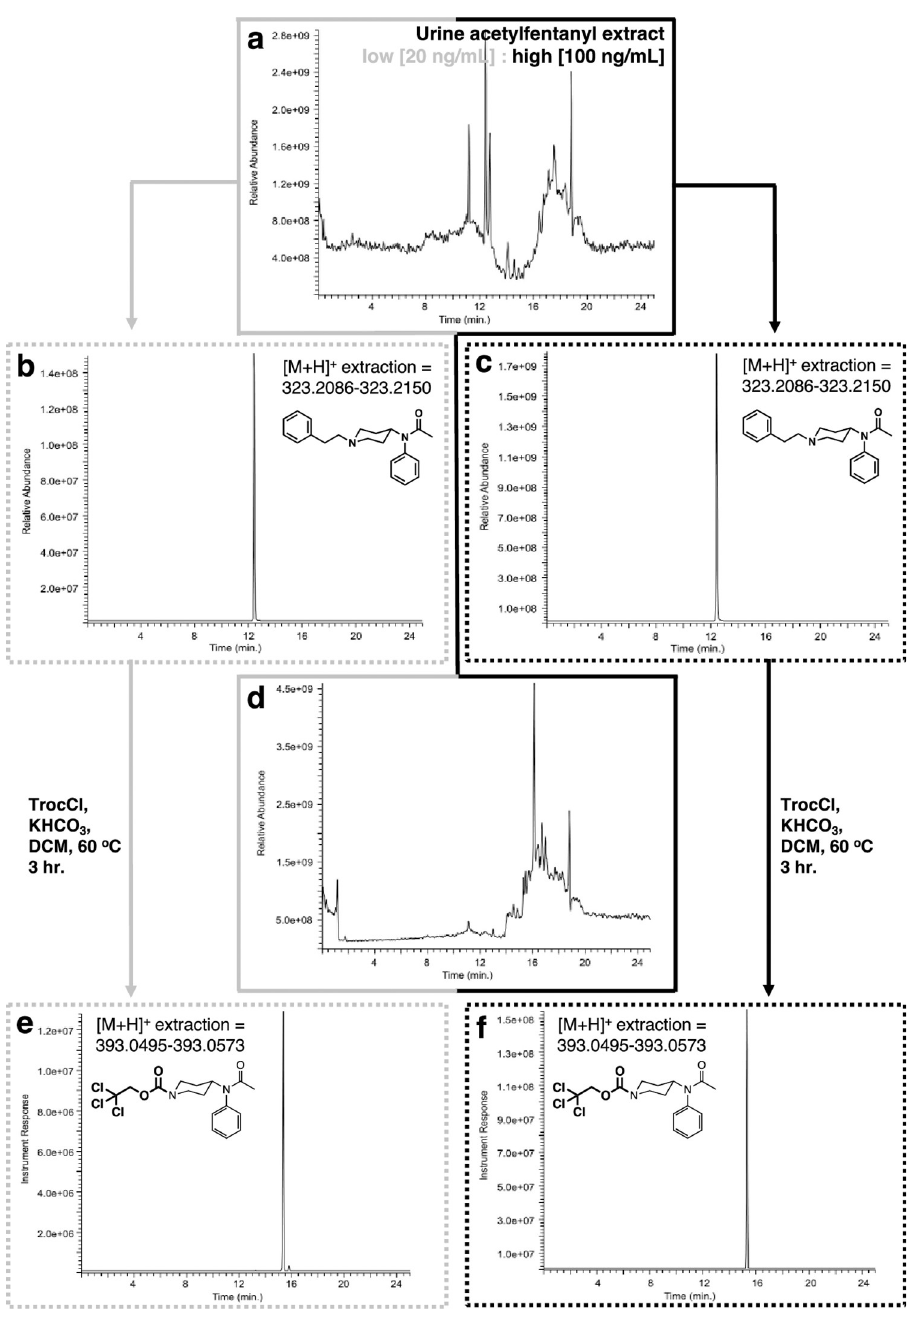
Fig 14. Analysis by HR-LC-MS of extraction and reaction of acetylfentanyl with Troc-Cl when spiked in urine. (a) Total ion chromatogram (TIC) of extracted urine sample; (b) extracted ion ([M+H] + = 323.2118 ± 5 ppm) for acetylfentanyl (rt = 12.46 min.) for low concentration urine sample (20 ng/mL); (c) extracted ion ([M+H] + = 323.2118 ± 5 ppm) for acetylfentanyl for high concentration urine sample (100 ng/mL); (d) Total ion chromatogram (TIC) of the reaction of extracted urine sample with Troc-Cl; (e) extracted ion ([M+H + ] = 393.0534 ± 5 ppm) for Troc- norfentanyl for low concentration spiked urine sample; (f) extracted ion ([M+H + ] = 393.0534 ± 5 ppm) for Troc- norfentanyl for the high concentration spiked urine sample showing its appearance at rt = 15.42 min.